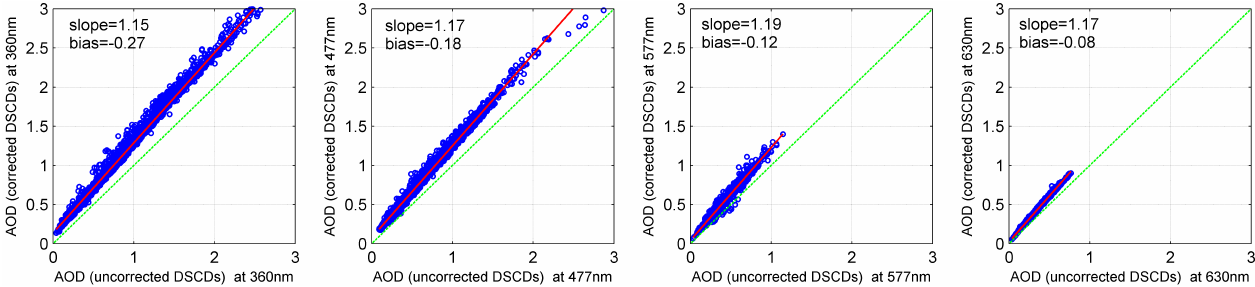
Fig. 12. Scatter plots of the total AODs at 360, 477, 577, and 630nm retrieved from the uncorrected and corrected O 4 DSCDs obtained from the MAXDOAS measurements in Beijing. Also indicated are the biases and the slopes of the linear regression fits (red lines).